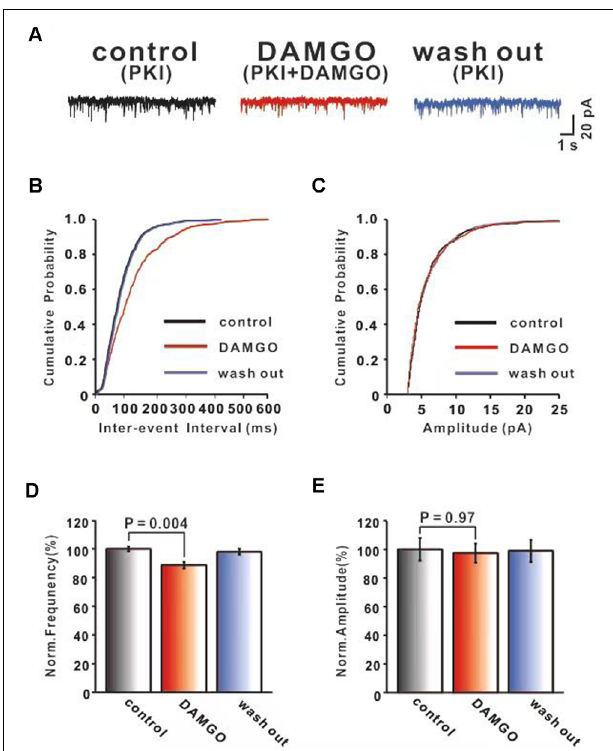
FIGURE 3 | MOR activation inhibits PF-PC synaptic transmission after blocking postsynaptic MOR signaling pathway. (A) Representative traces of PF-PC mEPSCs in control (1 µ M PKI), DAMGO (2 µ M DAMGO + 1 µ M PKI), and washout conditions (1 µ M PKI). (B,C) Cumulative probability plots of PF-PC mEPSCs frequency (interevent interval) (B) and amplitude (C) in control (1 µ M PKI), DAMGO (2 µ M DAMGO +1 µ M PKI), and washout conditions (1 µ M PKI). (D,E) Bar graphs showing the effects of DAMGO (2 µ M) on the PF-PC mEPSCs frequency (D) and amplitude (E) in the presence of PKI in internal